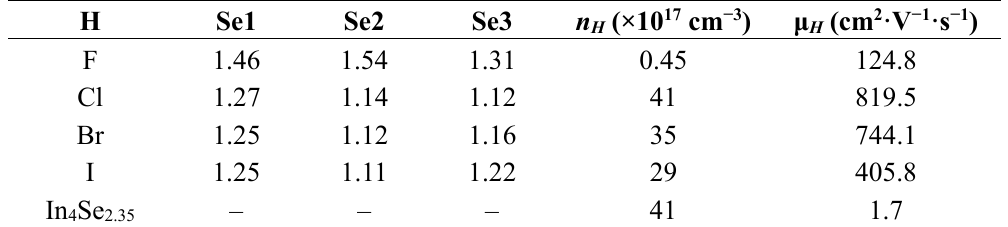
Table 5. Formation energies in eV at each selenium site for the compositions of In 4 Se 3 − x H 0.03 ( x = 0.06; H = F, Cl, Br, I) and room temperature carrier concentrations and Hall mobilities of the crystals of In 4 Se 3 − x H 0.03 ( x = 0.68; H = F, Cl, Br, I) and In 4 Se 2.35